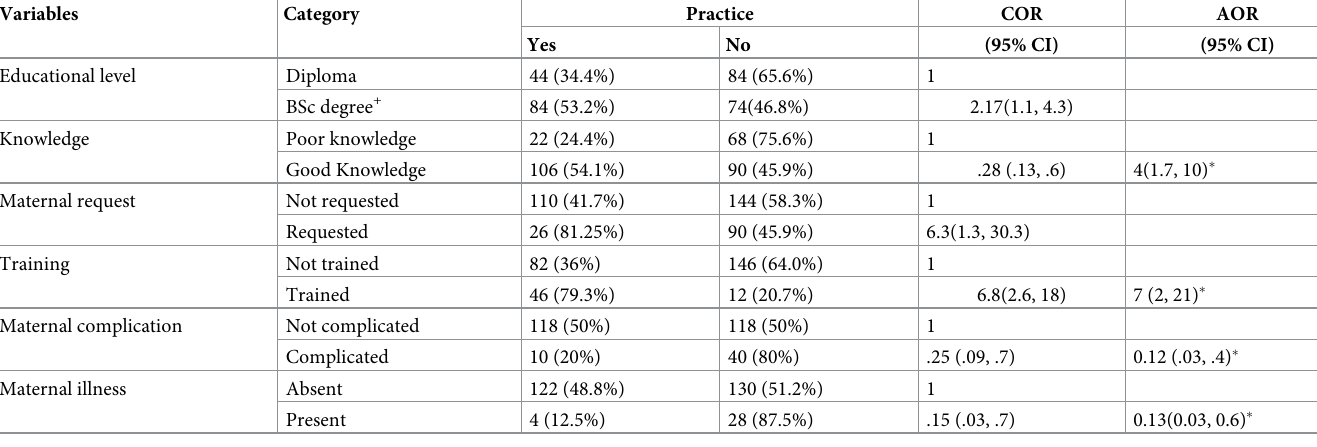
Table 3. Bivariate and multivariate logistic regression for factors associated with practice of skin-to-skin contact, in health care providers giving newborn care observation in Ilu Abba Bor and Bunno Beddelle Zones health facilities, Oromia, Ethiopia 2017.